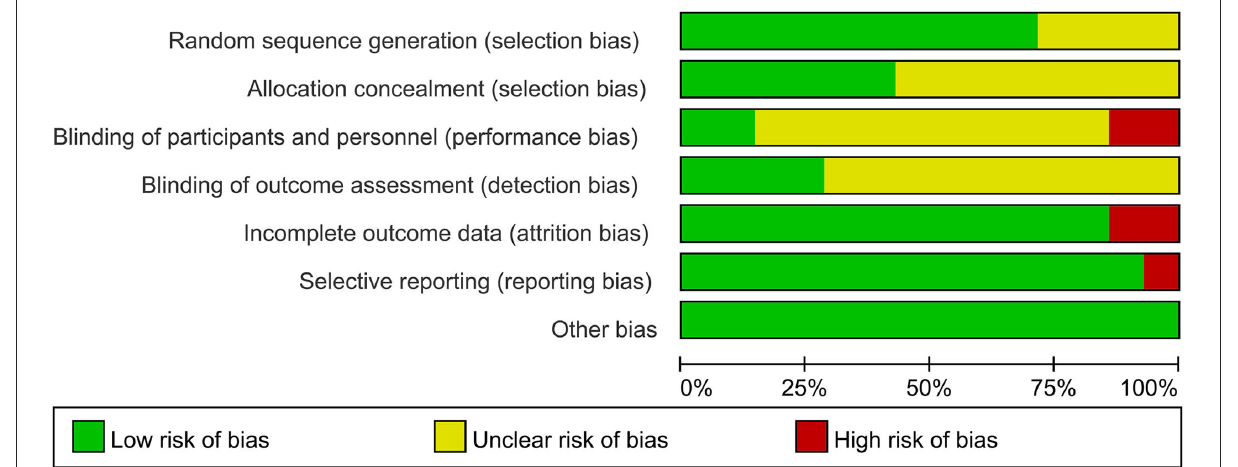
FIGURE2 Risk of bias assessment.